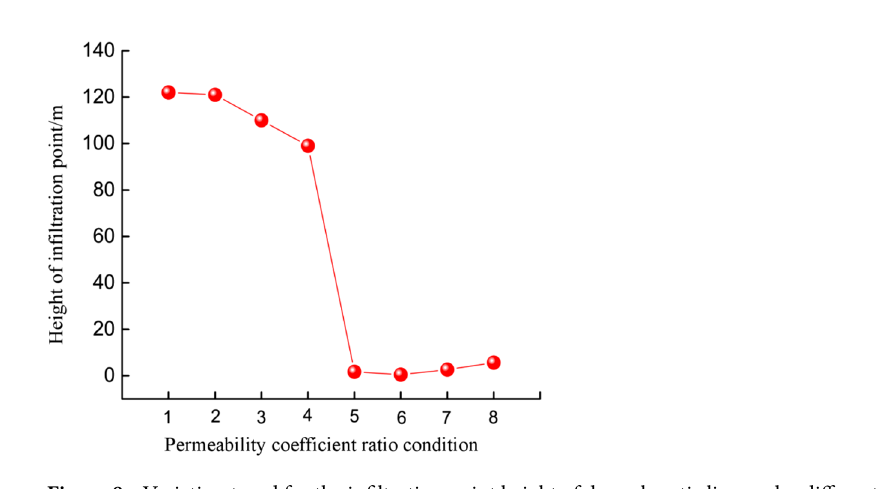
Figure 8. Variation trend for the infiltration point height of dam phreatic line under different permeability coefficient ratio